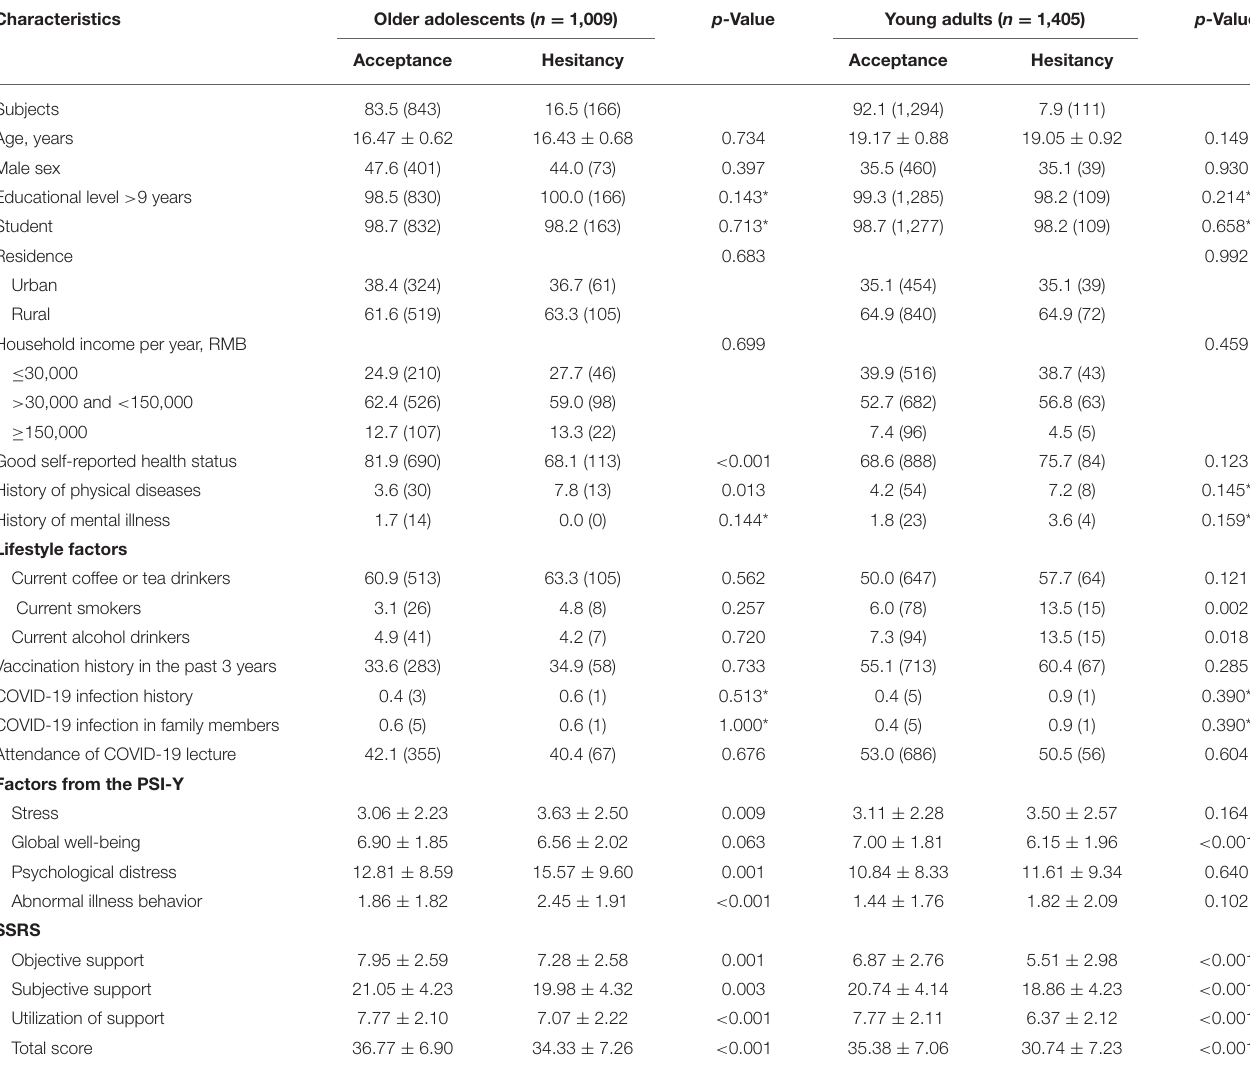
Values are presented as means ± SD or percents (n). For categorical variables, p-values are calculated using χ 2 or Fisher exact tests, and * p-values are obtained from Fisher exact tests; for continuous variables, p-values are calculated using the Wilcoxon rank-sum test. COVID-19, the coronavirus disease 2019; PSI-Y, Psychosocial Index-Young; SSRS, Social Support Rating